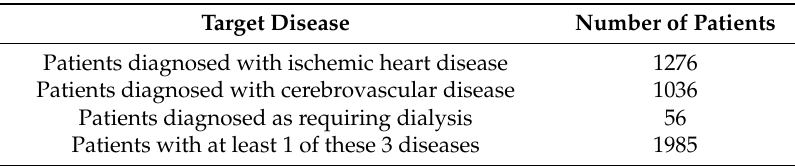
Table 1. Calculation results of disaster-vulnerable patients using KDB